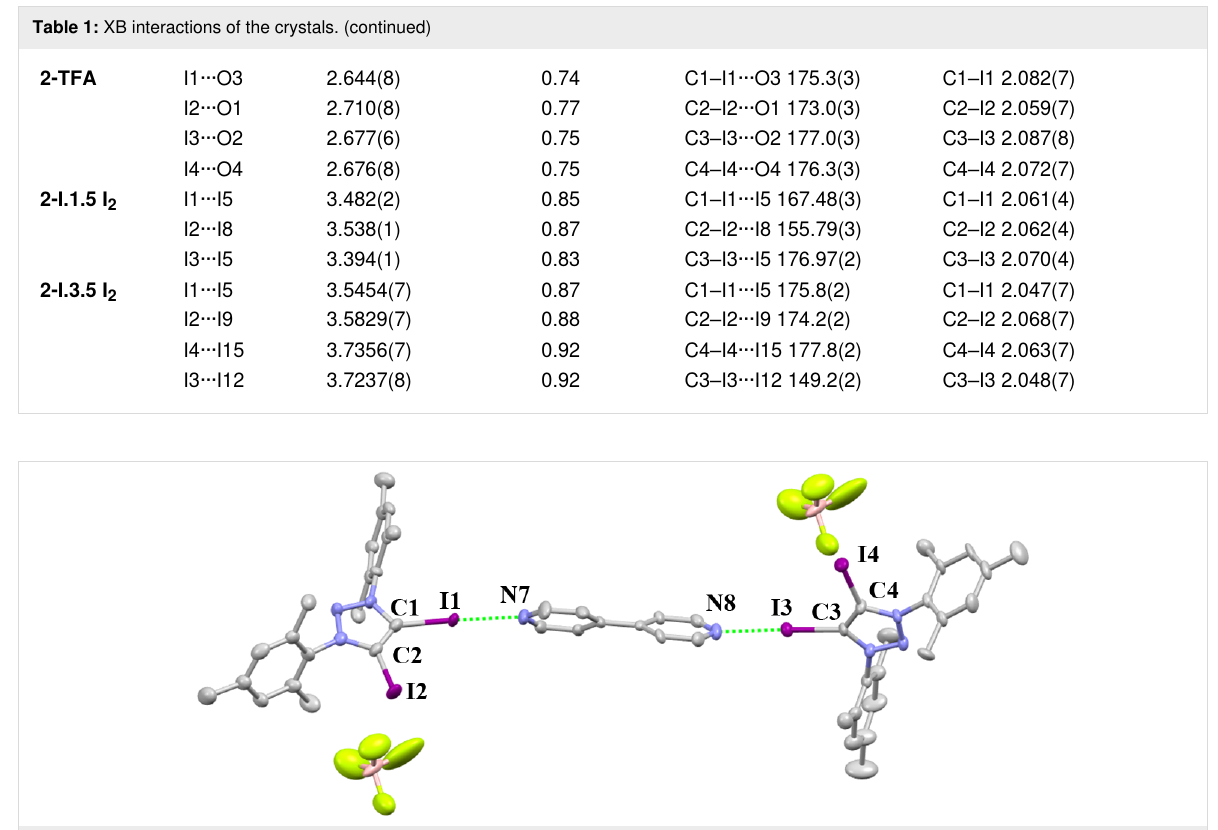
Figure 8: Packing structure of 2-BF 4 . 0.5bpy . Hydrogen atoms and dichloromethane have been omitted for clarity.